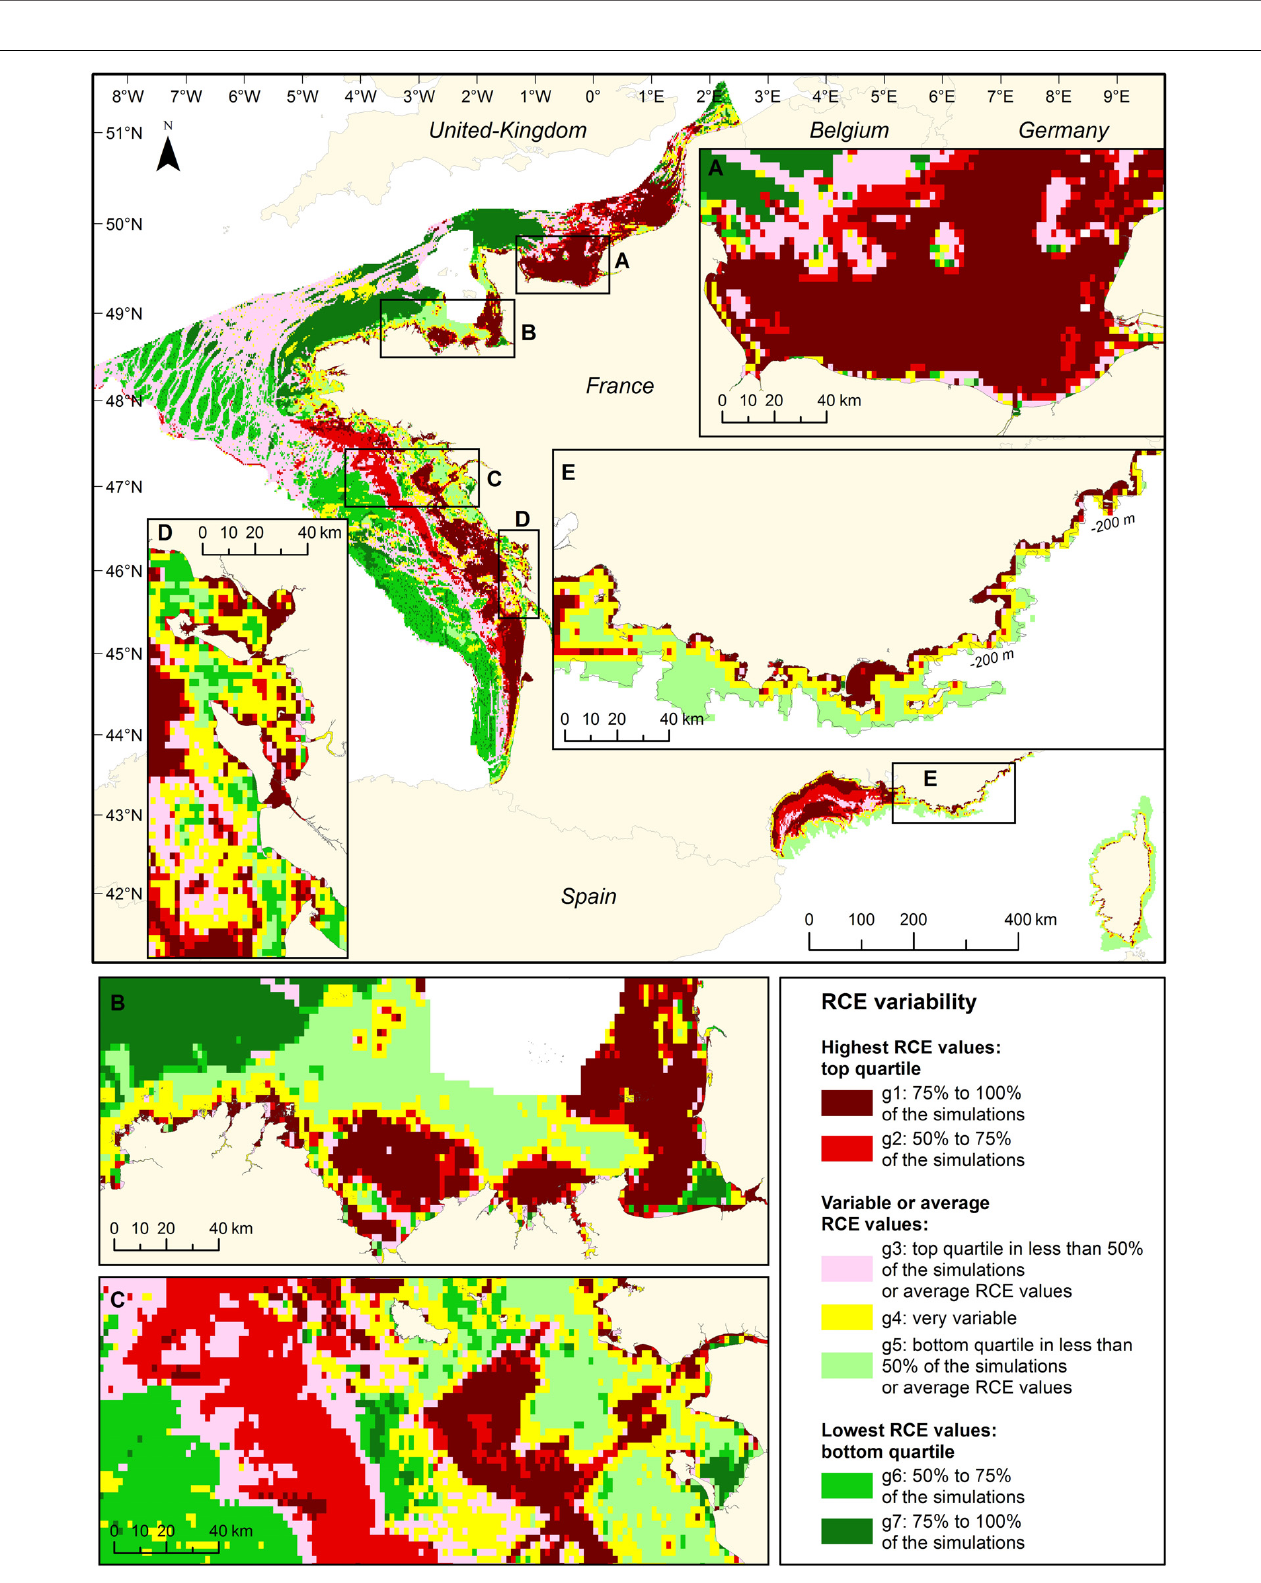
FIGURE 10 | Risk of Cumulative Effects variability (10,000 Monte-Carlo simulations). (A) Bay of Seine, (B) Normand-Breton Gulf, (C) Loire estuary, (D) Pertuis Charentais and Gironde estuary, (E) Marseille to French Riviera (Côte d’Azur).